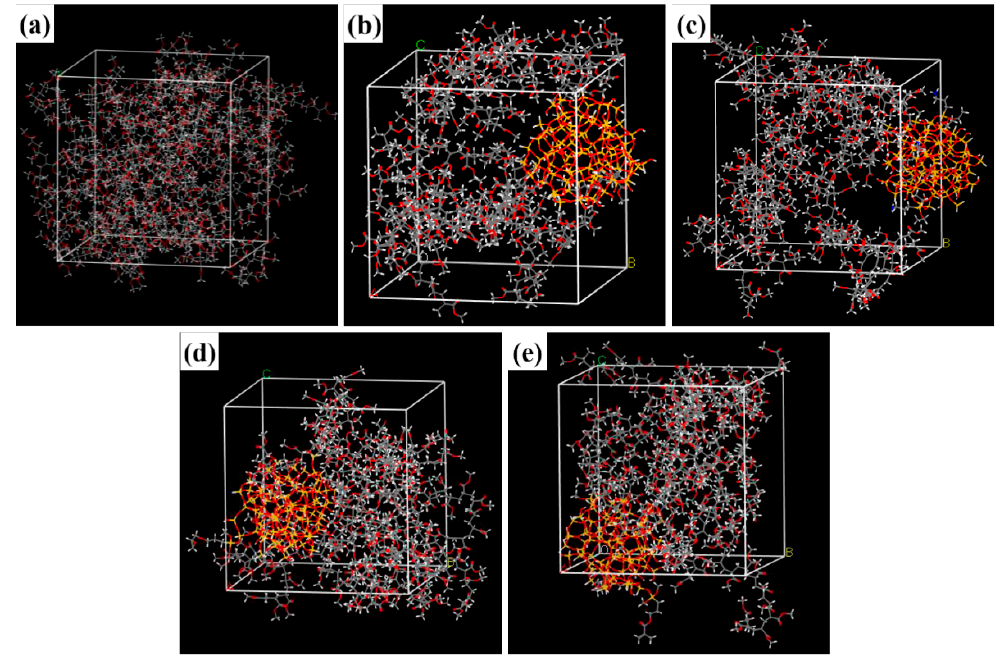
Figure 5. Models for MD simulation of composite system: ( a ). PMA, ( b ). PMA/SiO 2 , ( c ). PMA/KH550- SiO 2 , ( d ). PMA/KH560-SiO 2 , and ( e ). PMA/KH570-SiO 2 .